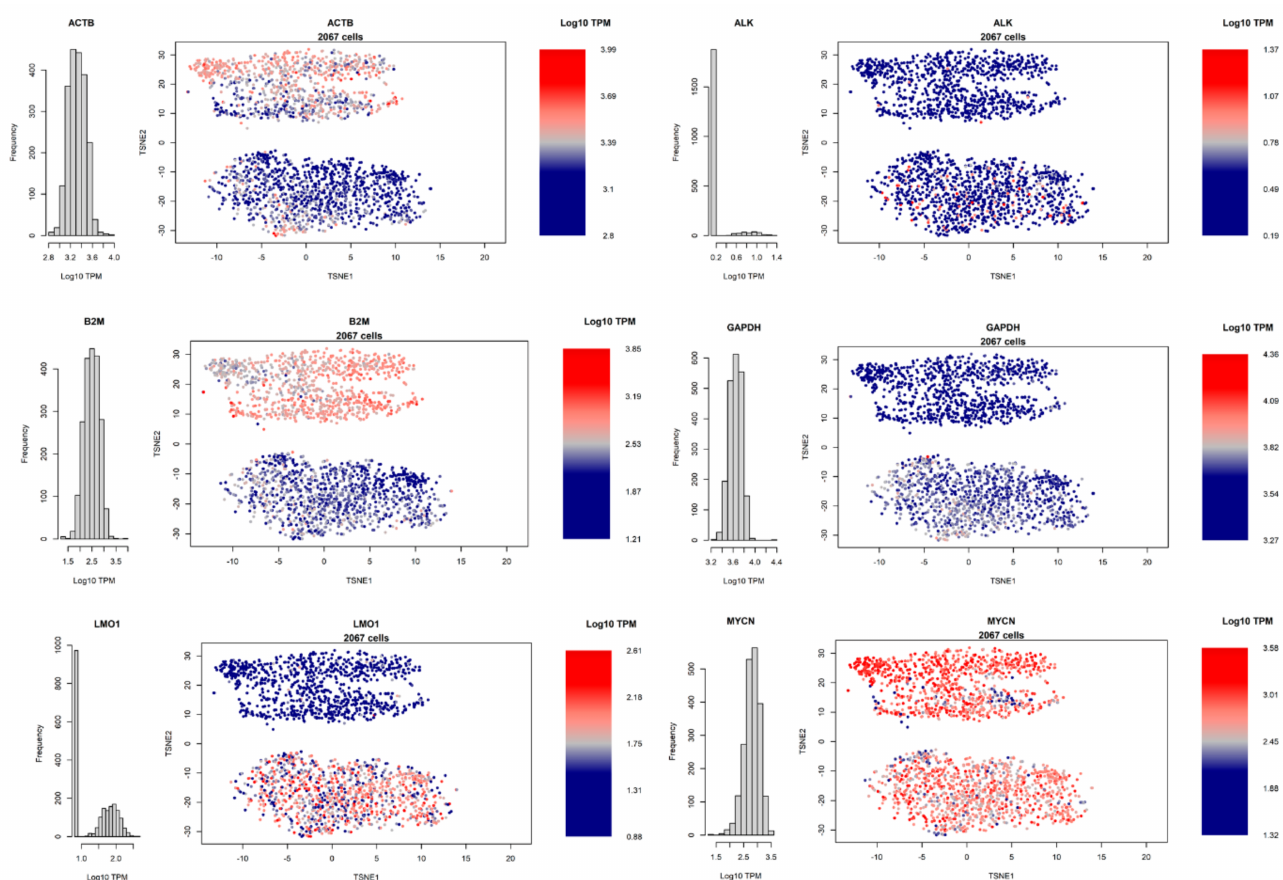
Figure 4. Single-cell distribution of selected genes, shown as log10 TPM. Color scaling is independent for each panel. Cartesian coordinates representing single cells are the same as Figure